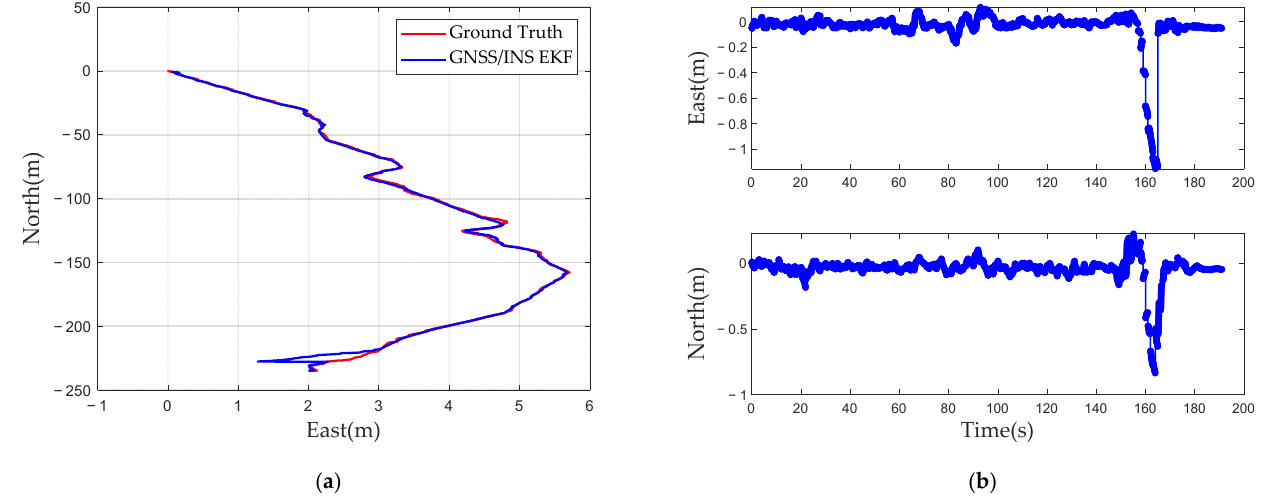
Figure 6. Trajectory and positioning errors in the east and north. ( a ) The trajectory of the vehicle in case 1. ( b ) The positioning errors in the east and north.